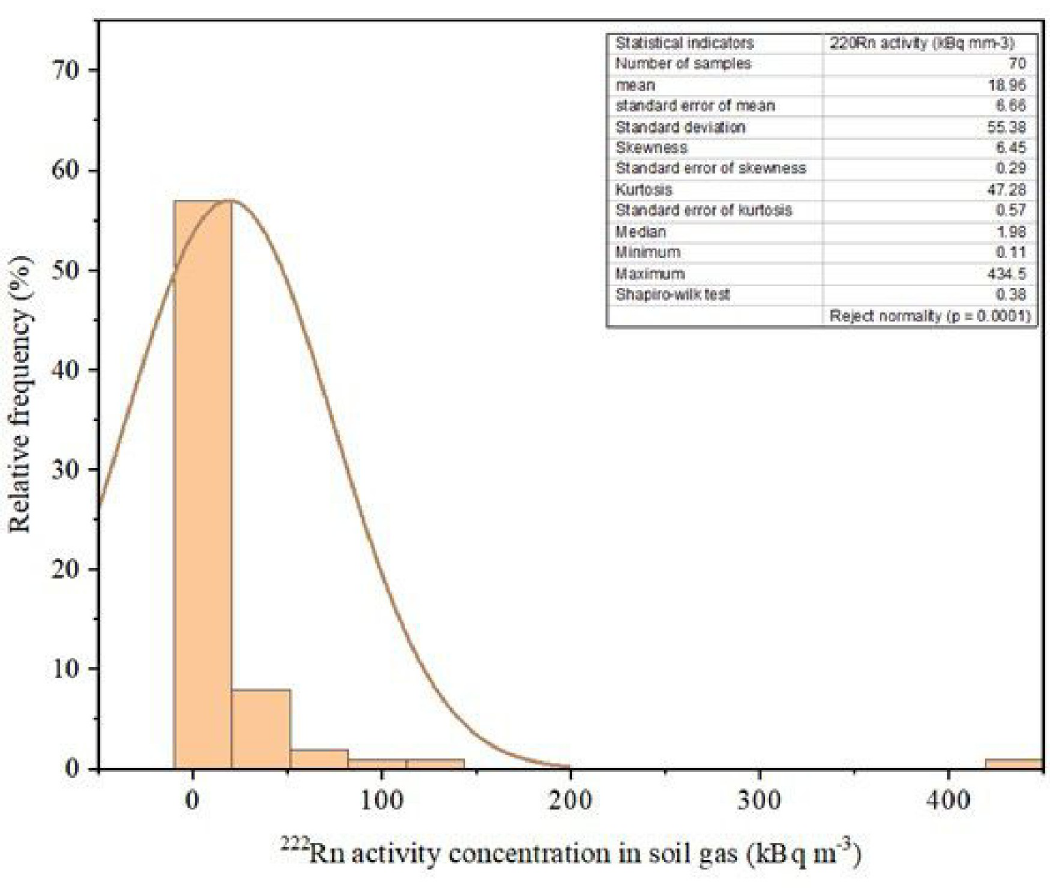
Fig 2. Histogram of radon activity concentration distribution in soil and statistical